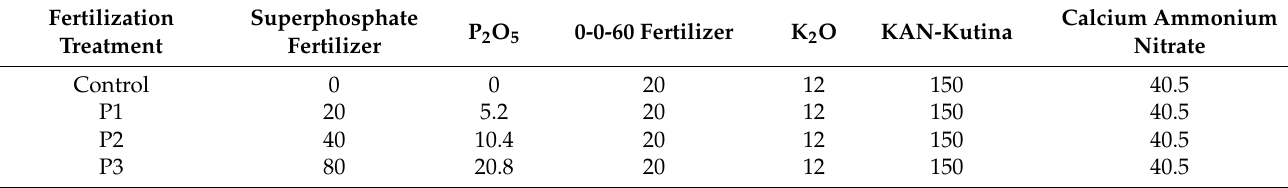
Table 1. Fertilization norms according to different fertilization treatments (in mg L − 1 substrate). Fertilization Treatment